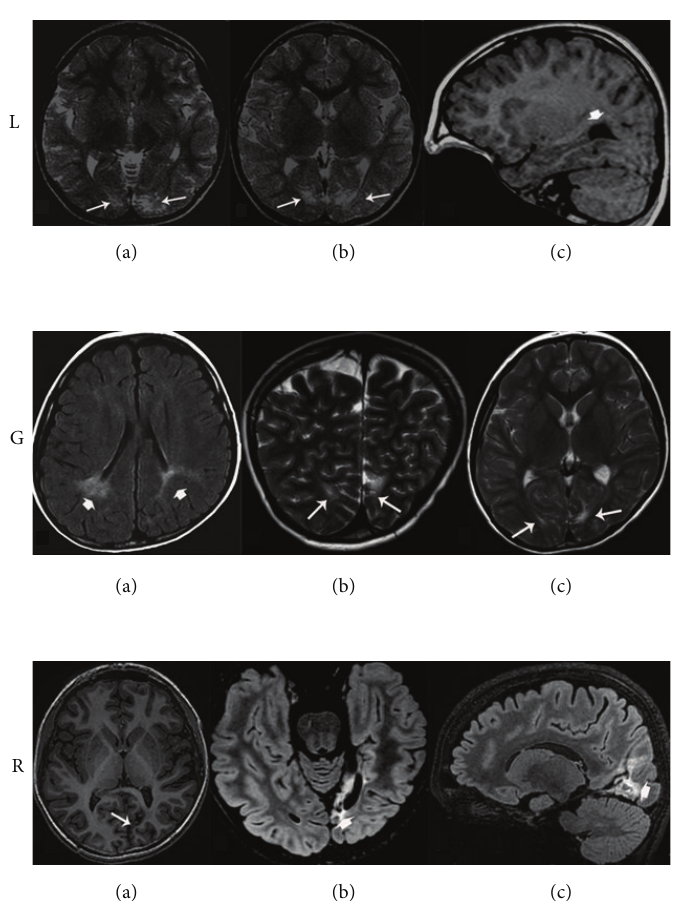
Figure 1: MRI scan for each patient. L.: (a), (b) Brain MRI (axial T2 and sagittal T1 weighted images) showing bilateral periventricular hyperintensities in the occipital lobes (white arrows) and dilatation of the occipital horn of the lateral ventricle (white arrowhead). G.: (a)– (c). Brain MRI (axial FLAIR, coronal and axial T2 weighted images) showing bilateral periventricular hyperintensities in the parietooccipital areas (see white arrowheads and arrows). R.: (a) Brain MRI (axial T1 weighted image) showing cortical-subcortical atrophy and abnormal cortical sulcation in the left temporooccipital area (white arrow). (b), (c). Brain MRI (axial and sagittal FLAIR weighted images) showing increased signal intensity in the left calcarine cortex and dilatation of the occipital horn of the left lateral ventricle (white